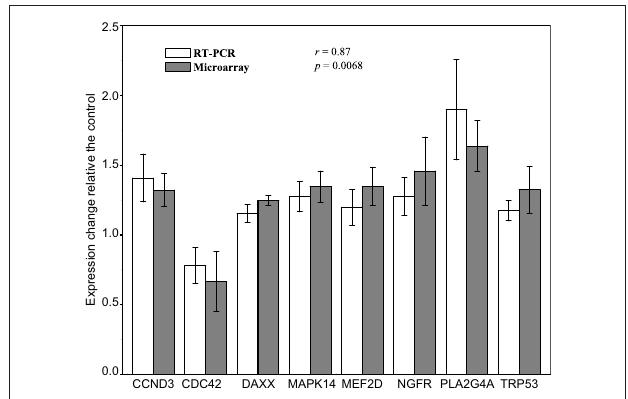
Figure 3 | Comparative plot of results from microarray and real-time rT-PCr verification for eight representative genes. Y axis represents the fold change of expression in 1-h nicotine-treated SH-SY5Y cells compared with the average expression in the control sample for that particular gene. For the qRT-PCR results, the expression of each gene was normalized to the average of control samples. Abbreviations: CCND3 , cyclin D3; CDC42 , cell division cycle 42 homolog; DAXX , Fas death domain-associated protein; MAPK14 , mitogen-activated protein kinase 14; MEF2D , myocyte enhancer factor 2d; NGFR , nerve growth factor receptor; PLA2G4A , phospholipase A2, group IVA; TRP53 , transformation-related protein 53.